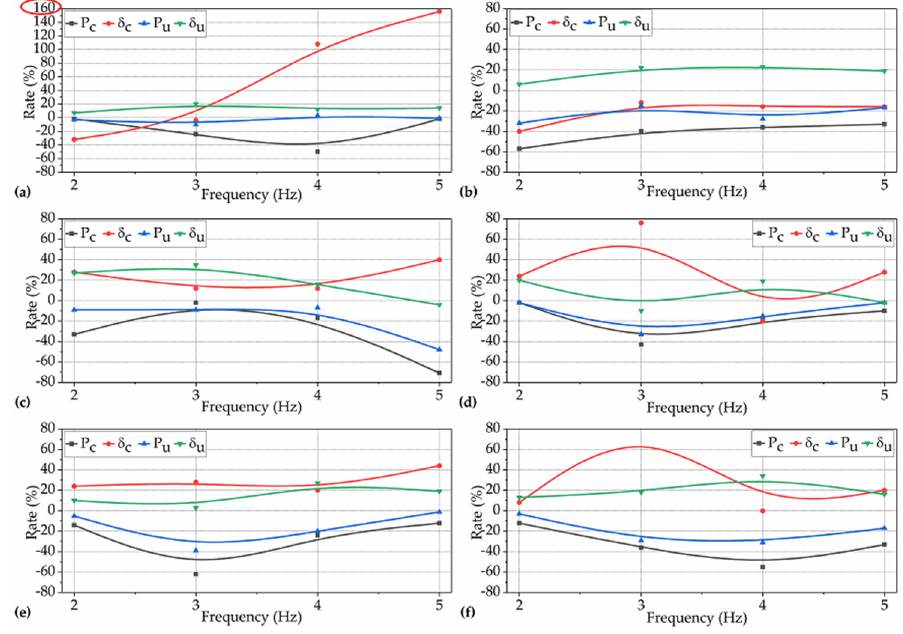
Figure 9. The rates of flexural properties with different vibration frequencies over the control averages under the operating conditions for Var. 1 at ages of ( a ) 1.5 h, ( b ) 8 h, ( c ) 15 h, ( d ) 23 h, ( e ) 36 h, and ( f ) 48 h.